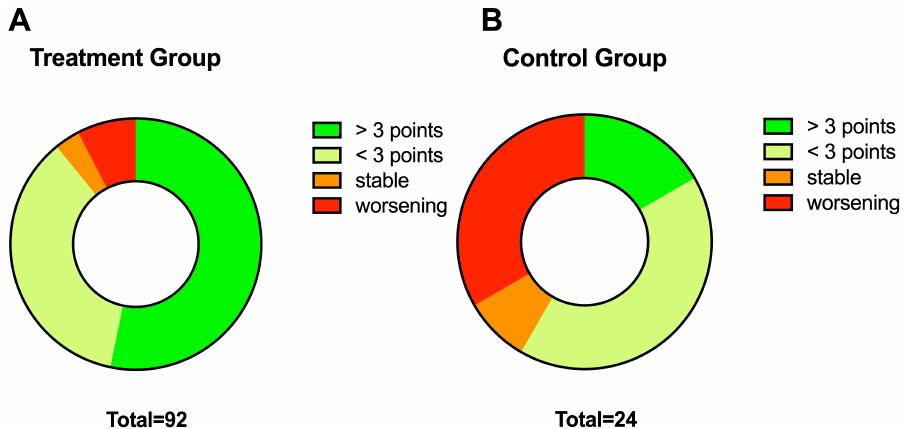
Figure 2. This figure shows the comparative results in term of recovery between the treatment group and the control group. ( A ) the graph shows the results obtained in the treatment group; ( B ) the figure illustrates the results in the control group.